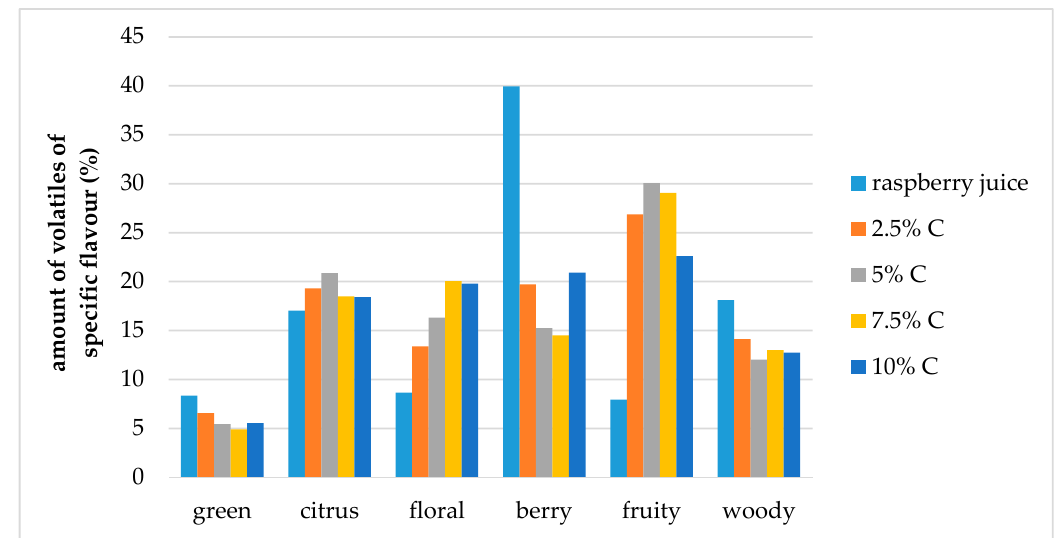
Figure 7. Amount of volatiles of specific flavor profile of raspberry juice and cellulose/raspberry complexes prepared by 15 min complexation (C—cellulose) after storage.